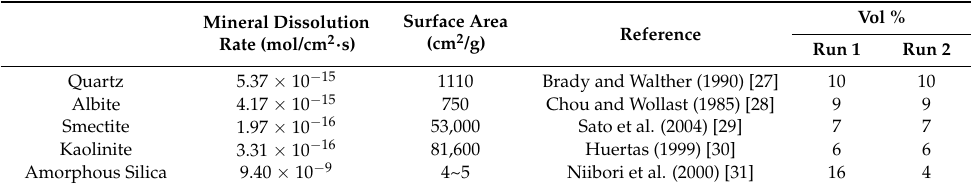
Table 2. Mineral dissolution rates and surface areas of silica-bearing phases loaded in the geochemical modeling as